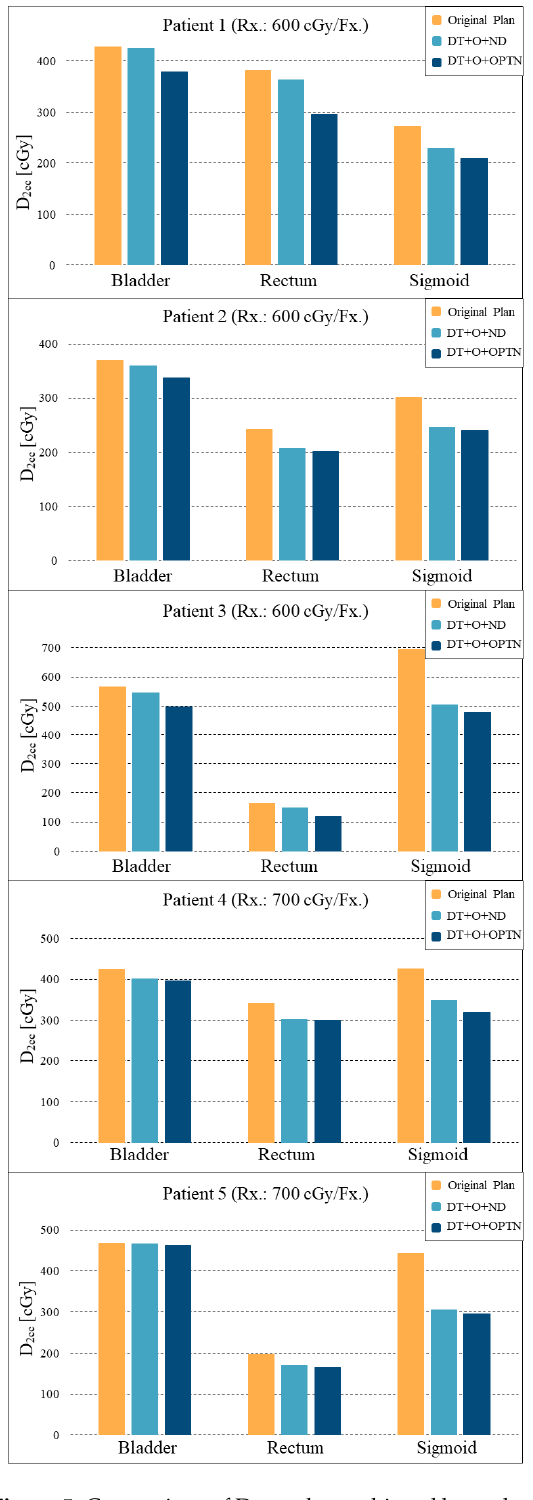
Figure 5. Comparison of D 2cc values achieved by each respective plans: original plan (yellow), DMBT + O + ND (light blue), and DMBT + O + OptN (dark blue). DMBT + O + ND: the original ovoids (O) and needles (ND) with the conventional tandem replaced by the DMBT tandem, DMBT + O + OptN: the original ovoids with the DMBT tandem and the needles spatially optimized.